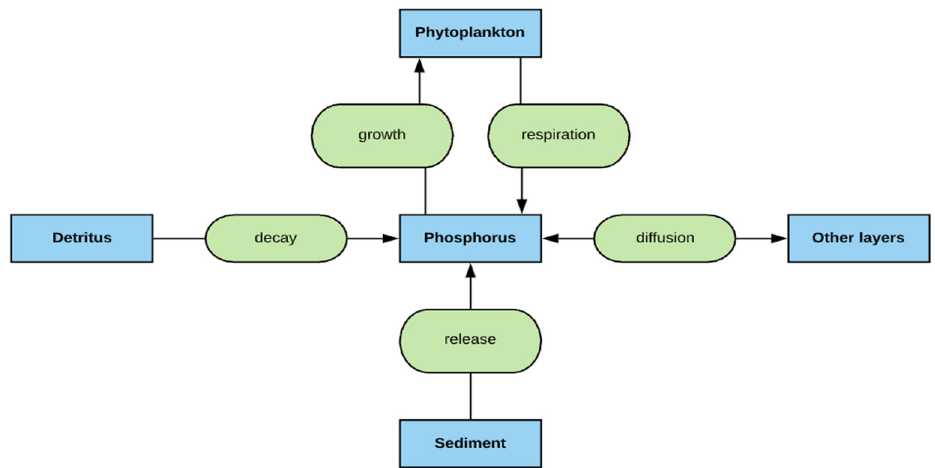
Figure 3. Schematic diagram of phosphorus cycle modeled by